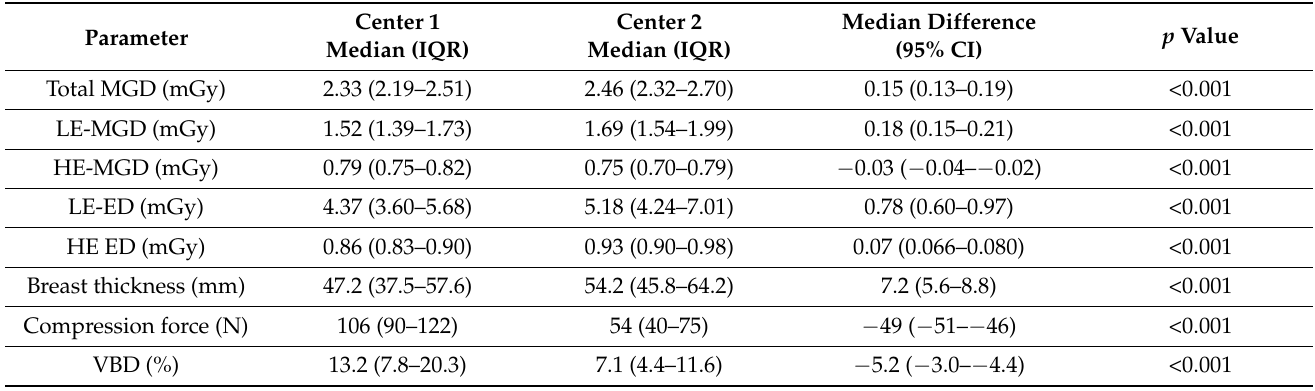
Figure 4. Per-view comparison between the two centers for the ( a ) total MGDs, ( b ) LE-MGD, ( c ) HE-MGD, ( d ) LE-ED, ( e ) HE-ED, ( f ) volumetric breast density (VBD), ( g ) breast thickness, and ( h ) compression force. Table 4. Comparison between total MGD, LE-MGD, and HE-MGD, and between parameters af- fecting MGD (ED, breast thickness, breast compression, and breast density) obtained from the two clinical